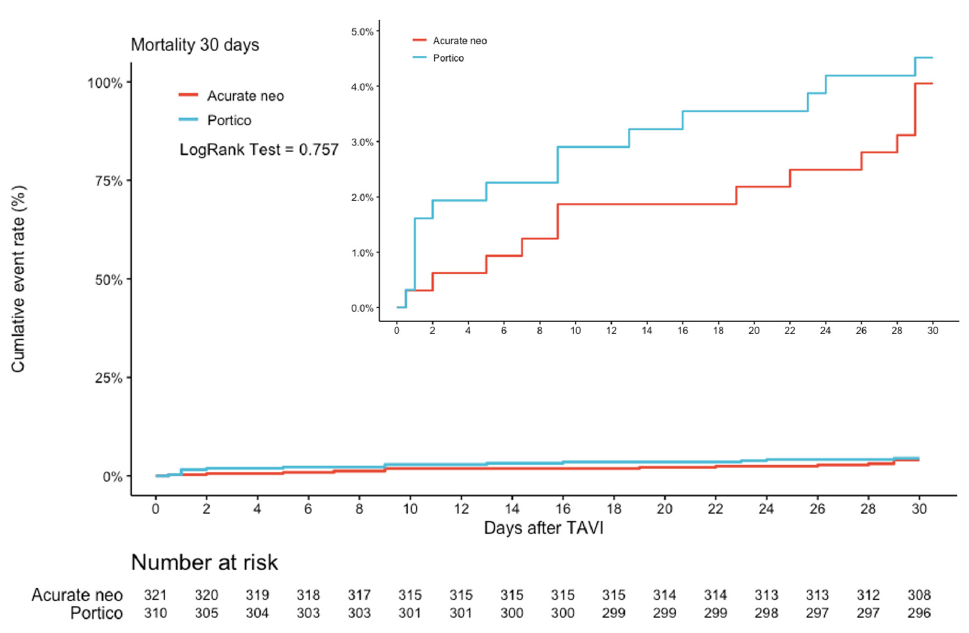
Figure 3. Kaplan–Meier cumulative event rate for the 30-day mortality. Cumulative event rate after 30 days for mortality in ACURATE neo vs. PORTICO (HR 1.13; 95% CI 0.53–2.40, p = 0.757).